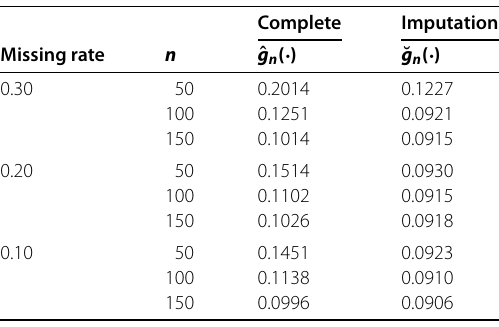
Table 3 The relative mean integrated square error of g ( · ) under different missing functions and different sample sizes obtained by two different methods for the simulated data Complete